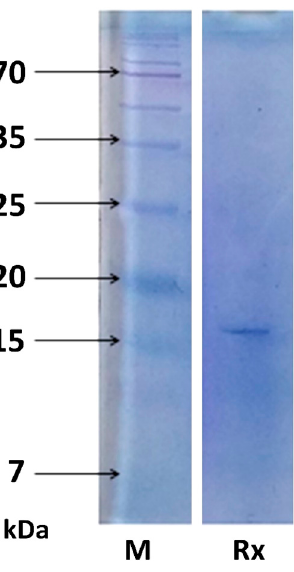
Figure 2. SDS-PAGE analysis of rugosa rose root crude polysaccharide (CPL-Rx). Lanes: M—standard marker; Rx—crude root polysaccharide.